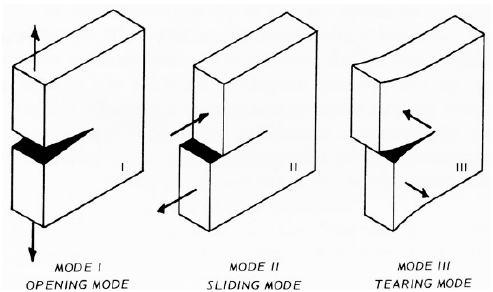
Figure 7. The three modes of propagation in fracture mechanics.